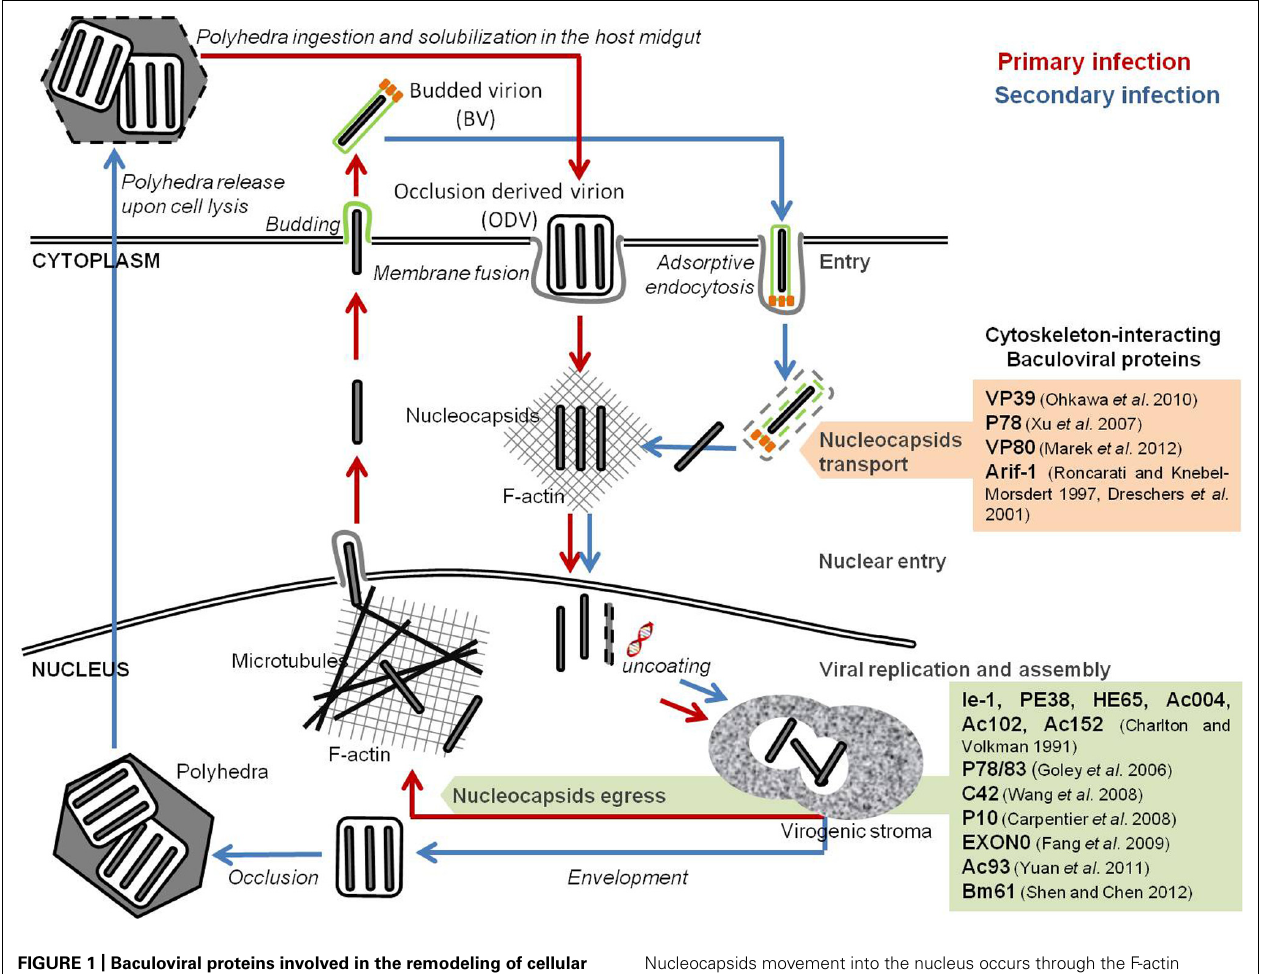
FIGURE 1 | Baculoviral proteins involved in the remodeling of cellular host cytoskeleton. Baculovirus infection induces a reconfiguration of the host cytoskeleton for intracellular traveling of nucleocapsids and virions.